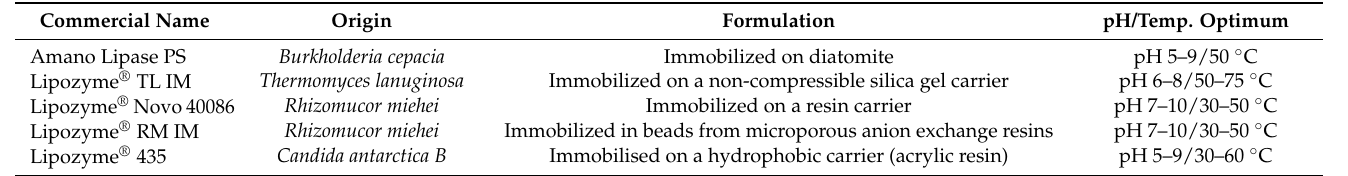
Table 4. Description and optimal operation conditions of the enzymes used